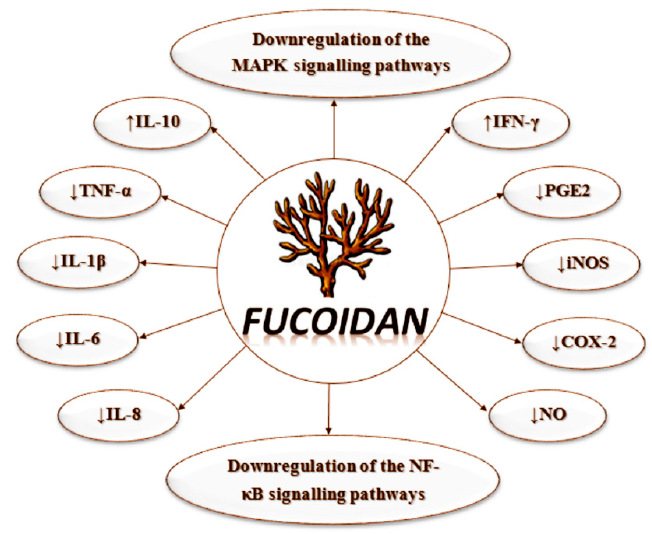
Figure 3. Putative mechanisms of anti-inflammatory activity of fucoidan.